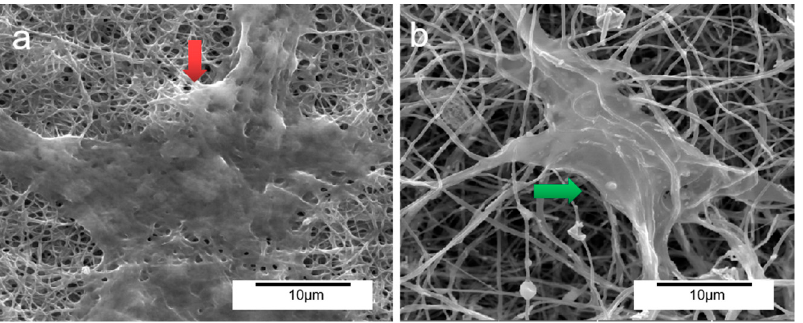
Figure 12. The morphology of human skin fibroblast adhesion on silk fibroin/gelatin (SF/GEL) ( a ) and silk fibroin/gelatin/kaolinite nanotubes/silver nanowire (SF/GEL/KA-N/AgNWs) ( b ) samples.